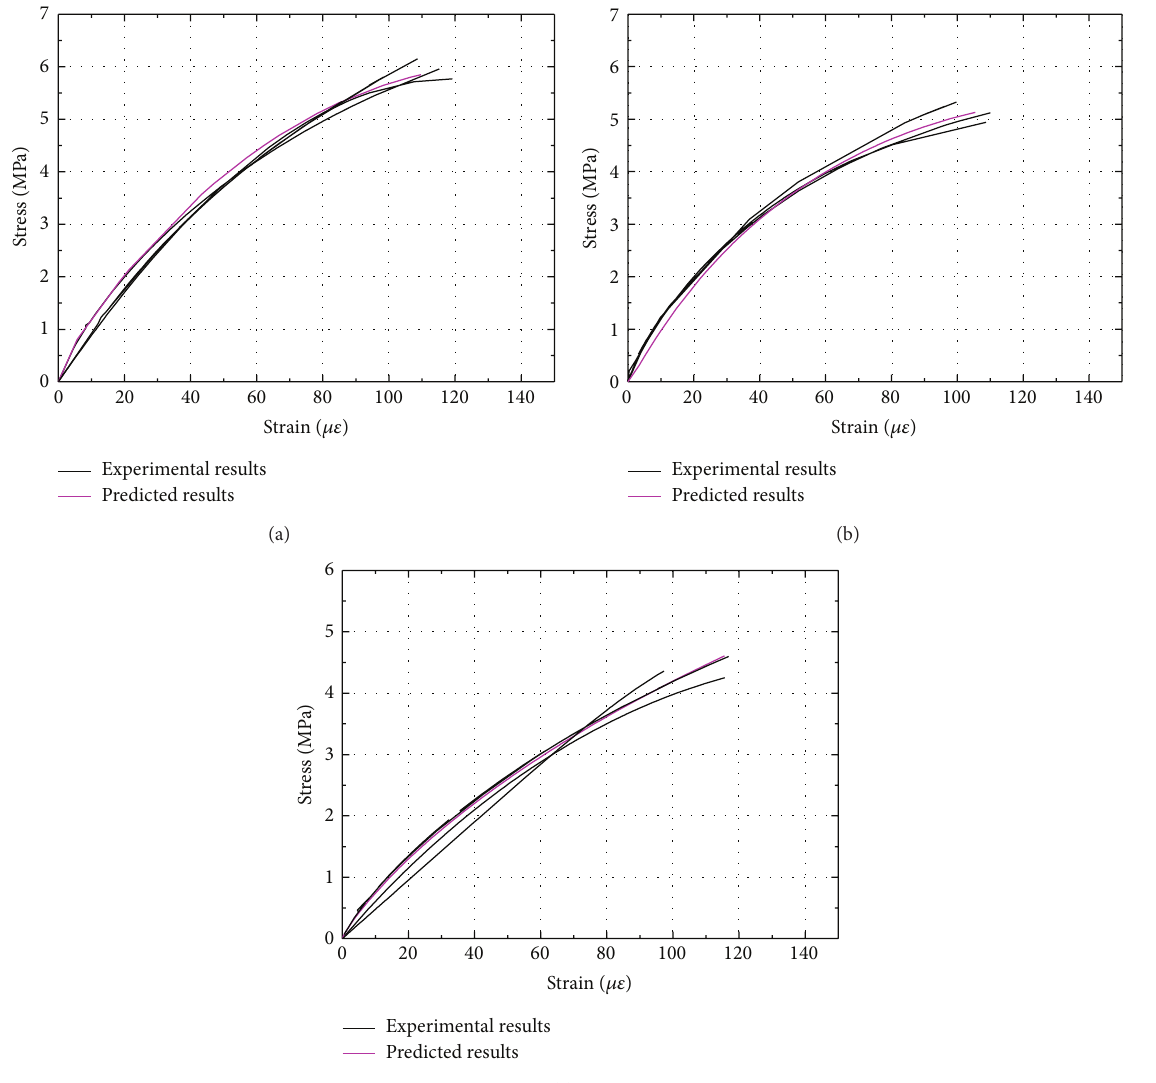
Figure 12: Comparison of predicted results with test data for concrete: (a) beam depth 40 mm; (b) beam depth 100 mm; (c) beam depth 150